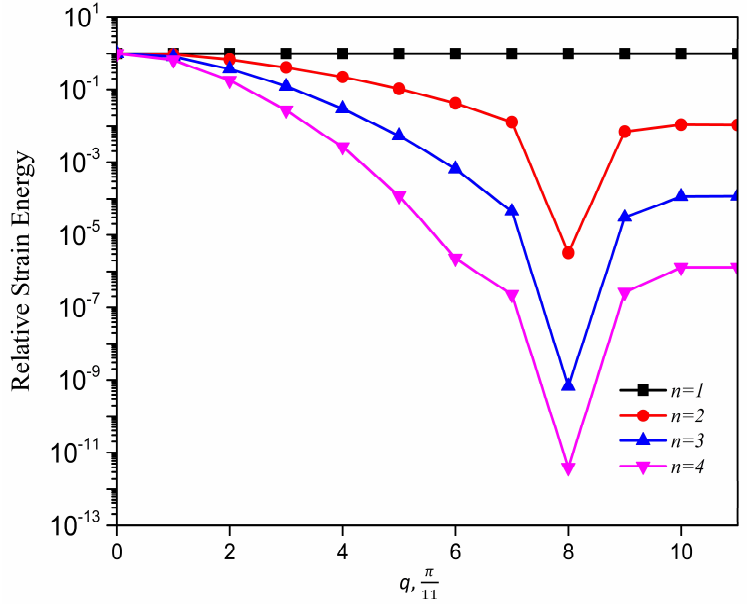
Figure 10. Relative strain energy against the Fourier parameter, q . A plot of strain energy at n relative to strain energy at n =1 against the Fourier parameter, q .